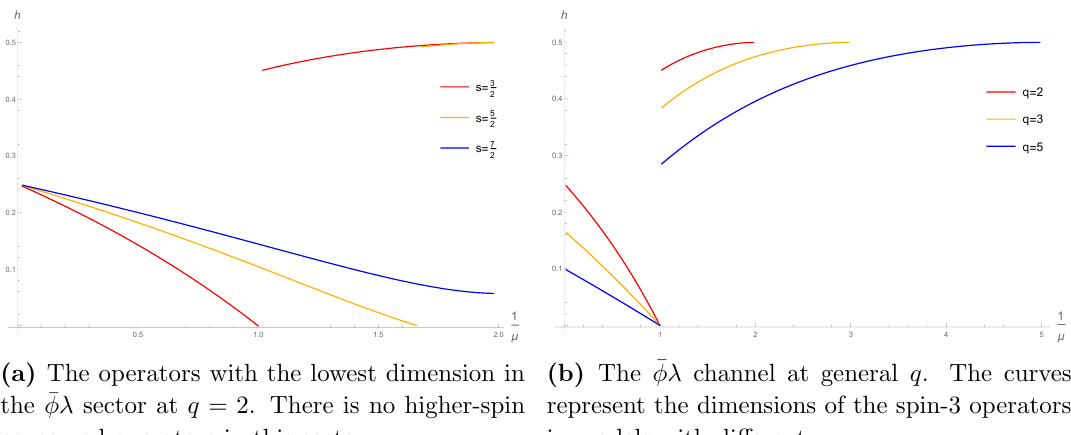
(a) The operators with the lowest dimension in (b) The (cid:22) (cid:30)(cid:21) channel at general q . The curves the (cid:22) (cid:30)(cid:21) sector at q = 2. There is no higher-spin represent the dimensions of the spin-3 operators conserved operators in this sector. in models with di(cid:11)erent q . Figure 15. The lowest dimensions of the fermionic operators in the h (cid:30) i (cid:22) (cid:21) i (cid:21) j (cid:22) (cid:30) j i and h (cid:30) i (cid:22) (cid:21) i G j (cid:22) j i four point functions. The plots illustrate how does the dimension change as a function of (cid:22) . The jumps of the curves are due to the fact that as (cid:22) becomes smaller than 1, the branch of operators with the lowest dimension when (cid:22) (cid:21) 1 ceases to exist so the operators with the second lowest dimensions become the \lowest" one at (cid:22) <